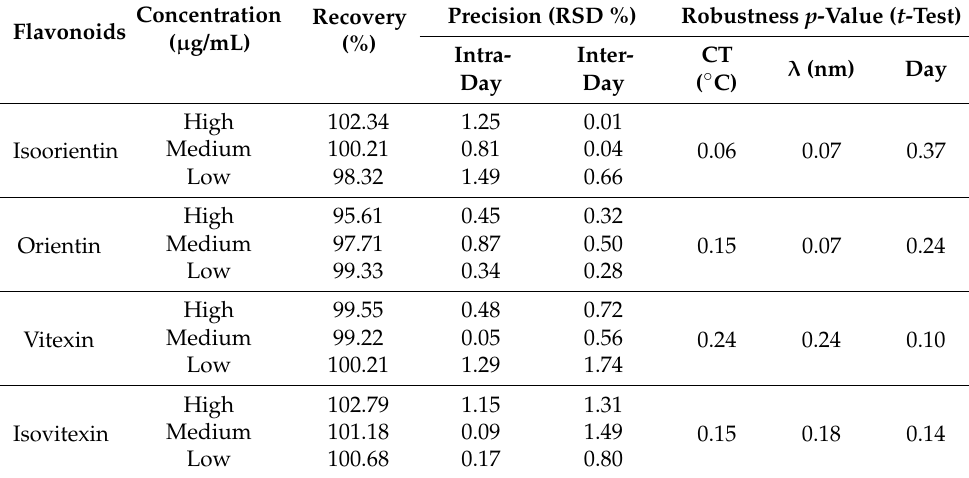
Table 2. Recovery (%), relative standard deviation (RSD %) and t -test ( p -value) of isoorientin, orientin, vitexin, and